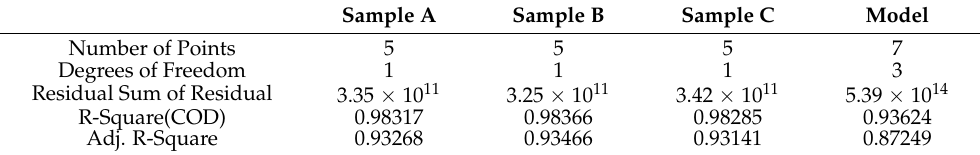
Table 7. Residual sum and R-square for tension–tension fatigue samples.